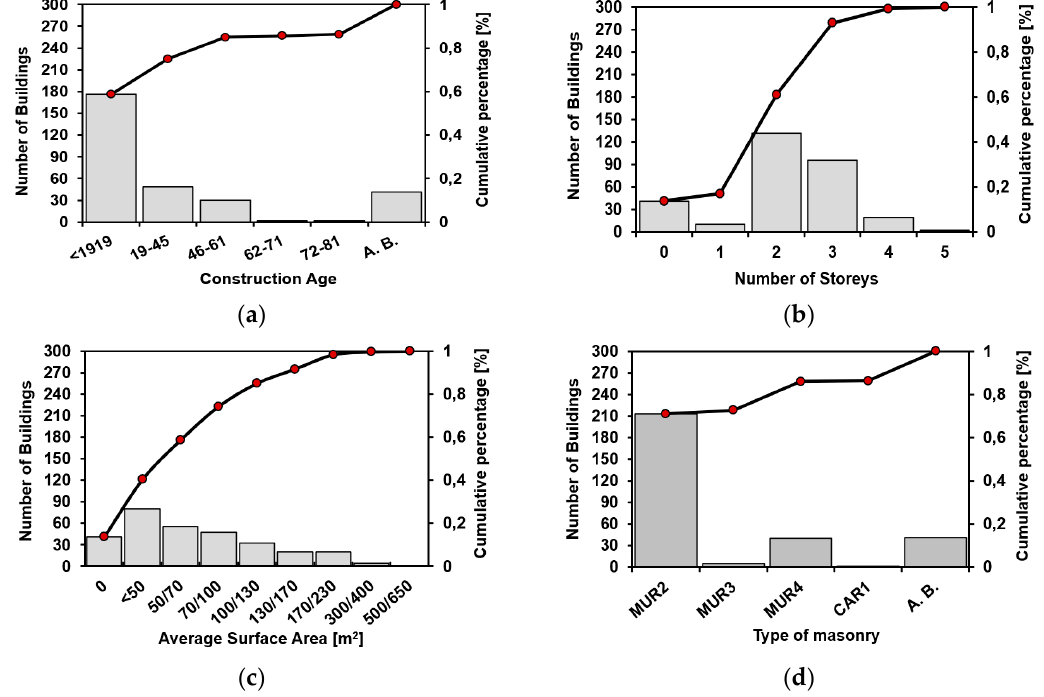
Figure 6. Street views of some building typologies inside the inspected historical centre of Baranello.